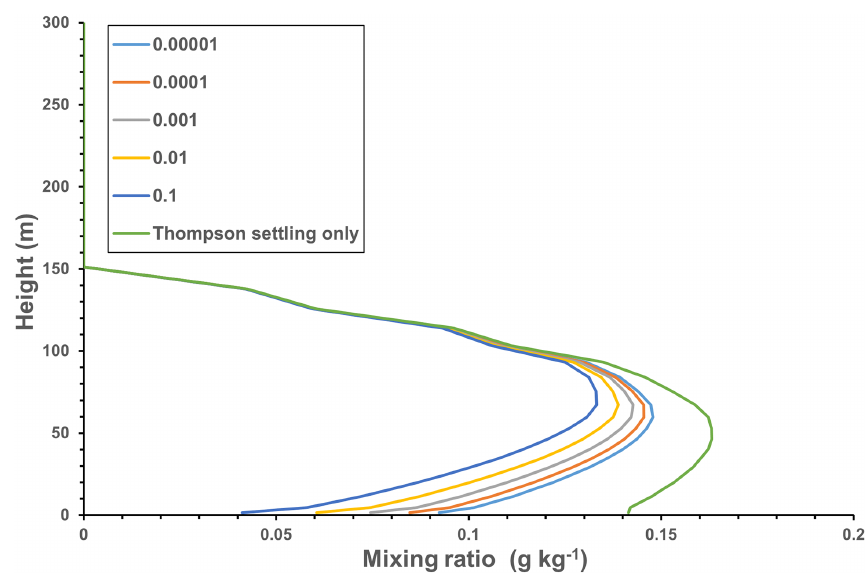
Figure 2. Q c profiles, 24h after the start of the integration and 18h after the end of the surface cooling, by 18K. Results are shown with the original MYNN (gravitational settling in Thompson microphysics only) and with a range of z 0c values (in meters). A time step, d t , of 60s was used with 101 eta